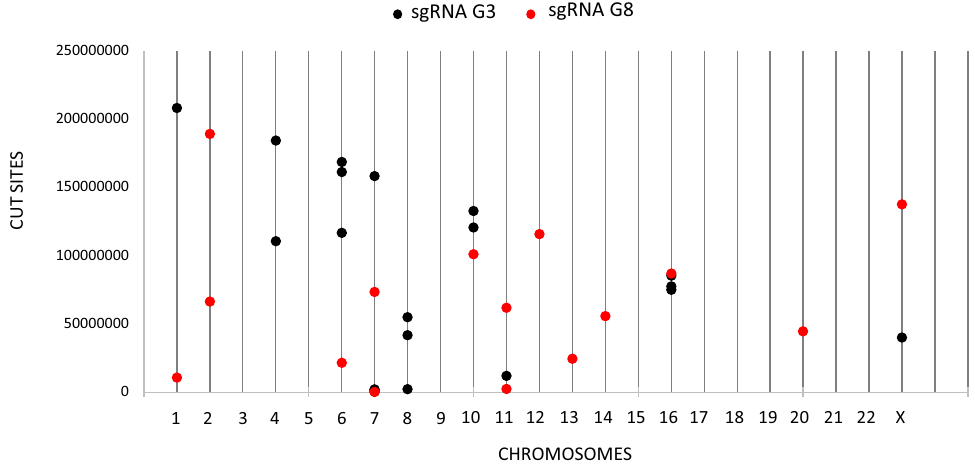
Figure 7. Predictable G3 and G8 sgRNA off-targets. The predictable off-targets were identified using the guide design verification tool available on the SYNTHEGO website. Their chromosomal distribution is shown in the figure.